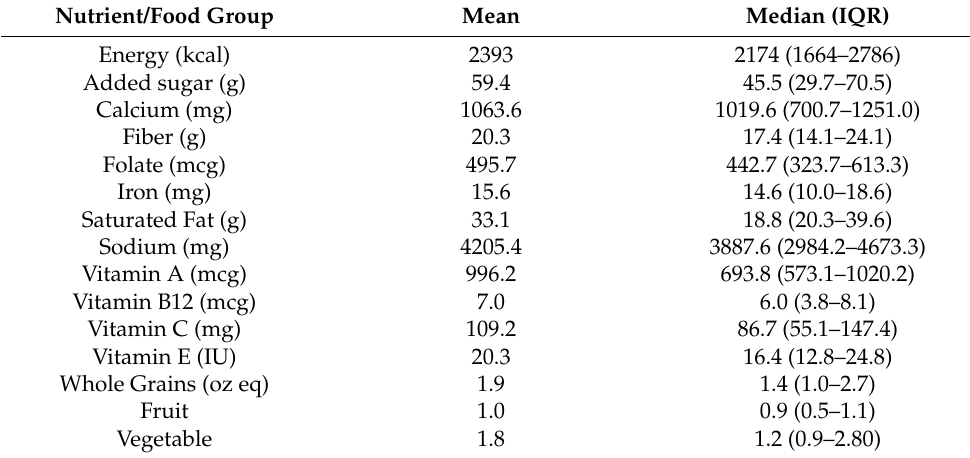
Table 4. Food Frequency Questionnaire-determined daily nutrient and food group intakes ( N = 37).